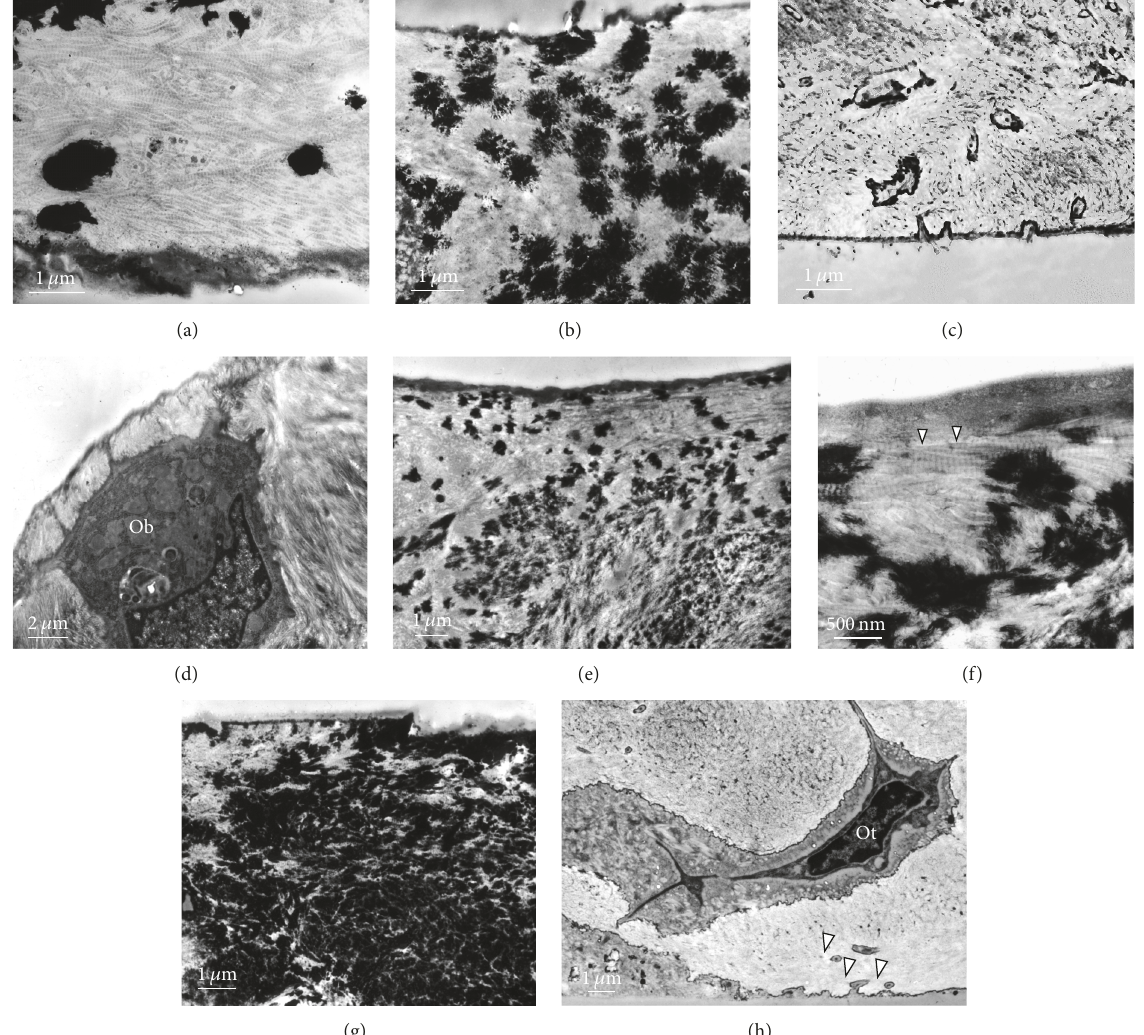
Figure 5: Transmission electron microscopy. The various stages of bone formation adjacent to the Ep surface could be observed at 12 weeks of healing. (a–c) At the bone-implant interface, osteoblasts (Ob) produce an unmineralised extracellular matrix, the osteoid, which undergoes progressive mineralisation. (d) Collagen fibrils are aligned parallel to the osteoblast surface. (e) Early mineralisation stage with patchy distribution of bone apatite (dark areas). (f) In high-resolution, the characteristic 67 nm cross-striated pattern of collagen fibrils (white arrows) can be observed, with accumulation of intra- and interfibrillar mineral. (g) Late mineralisation stage with diffuse distribution of bone apatite (dark areas). (h) An osteocyte (Ot) embedded within the mineralised matrix lies in close proximity to the implant surface with several dendritic processes residing within canaliculi (white arrows), sectioned longitudinally as well as transversally, extending towards the implant